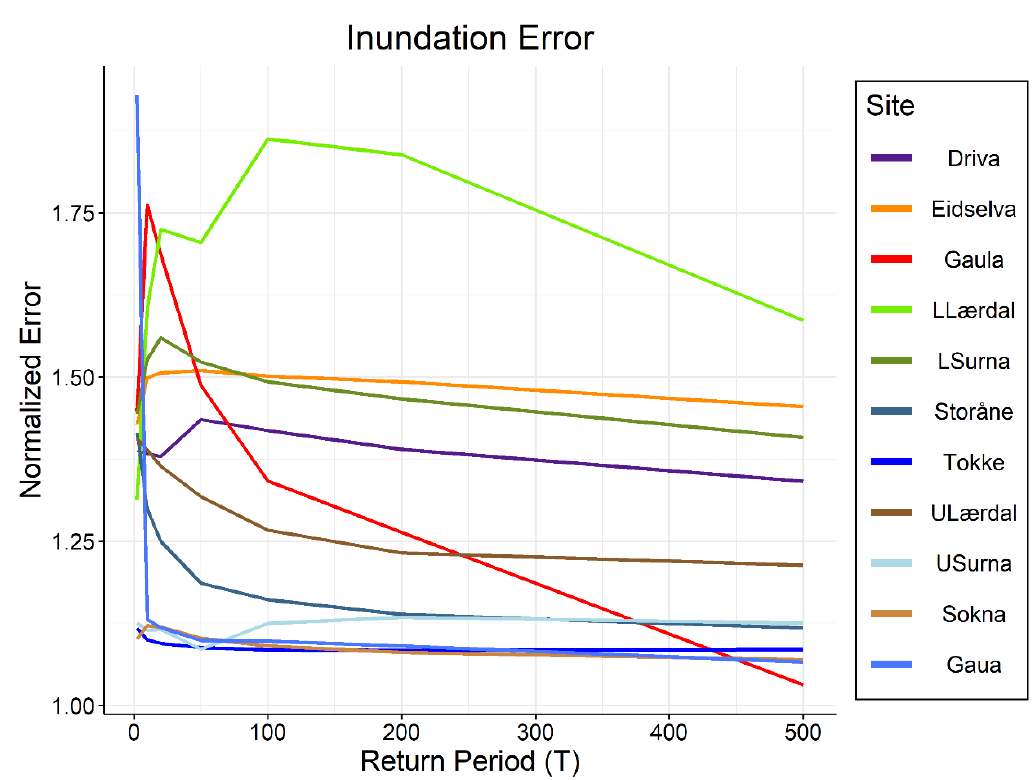
Figure 5. The inundation error comparison for the 11 sites. U and L prior to Lærdal and Surna abbreviate Upper and Lower.